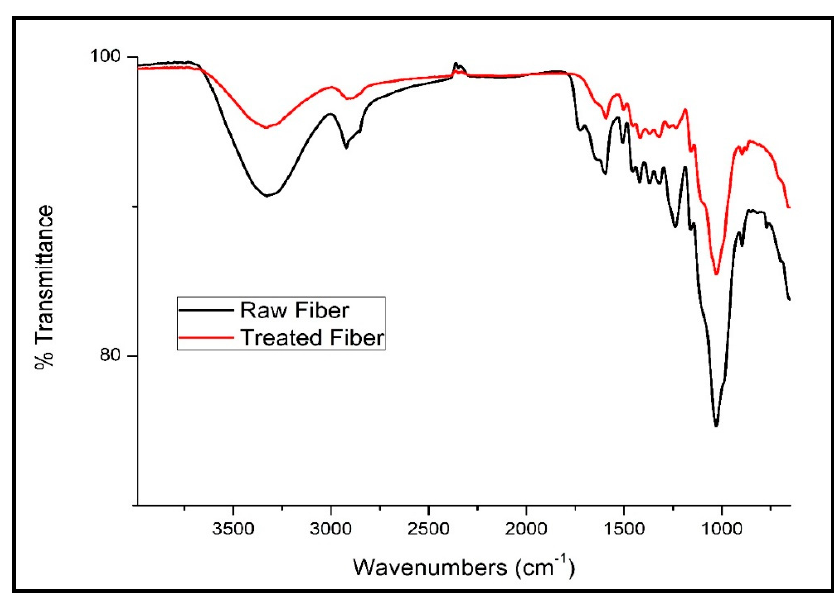
Figure 9. Attenuated total reflectance (ATR)–FTIR spectra of raw and alkali-treated fibers.